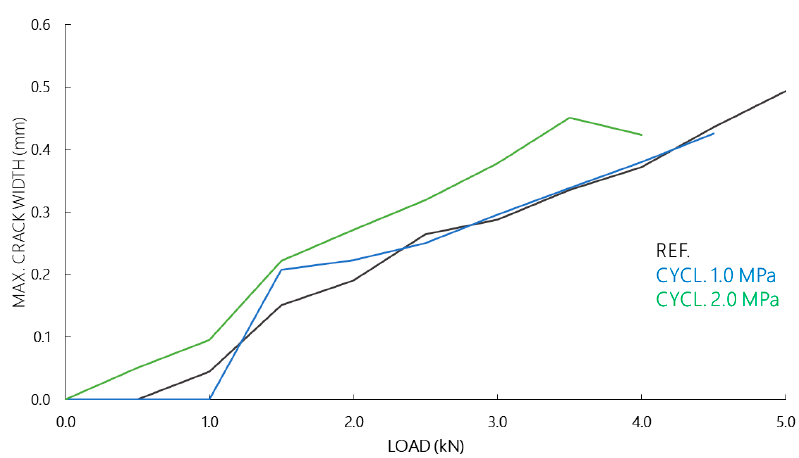
Figure 19. The maximum crack width observed in the sandwich beams per series.